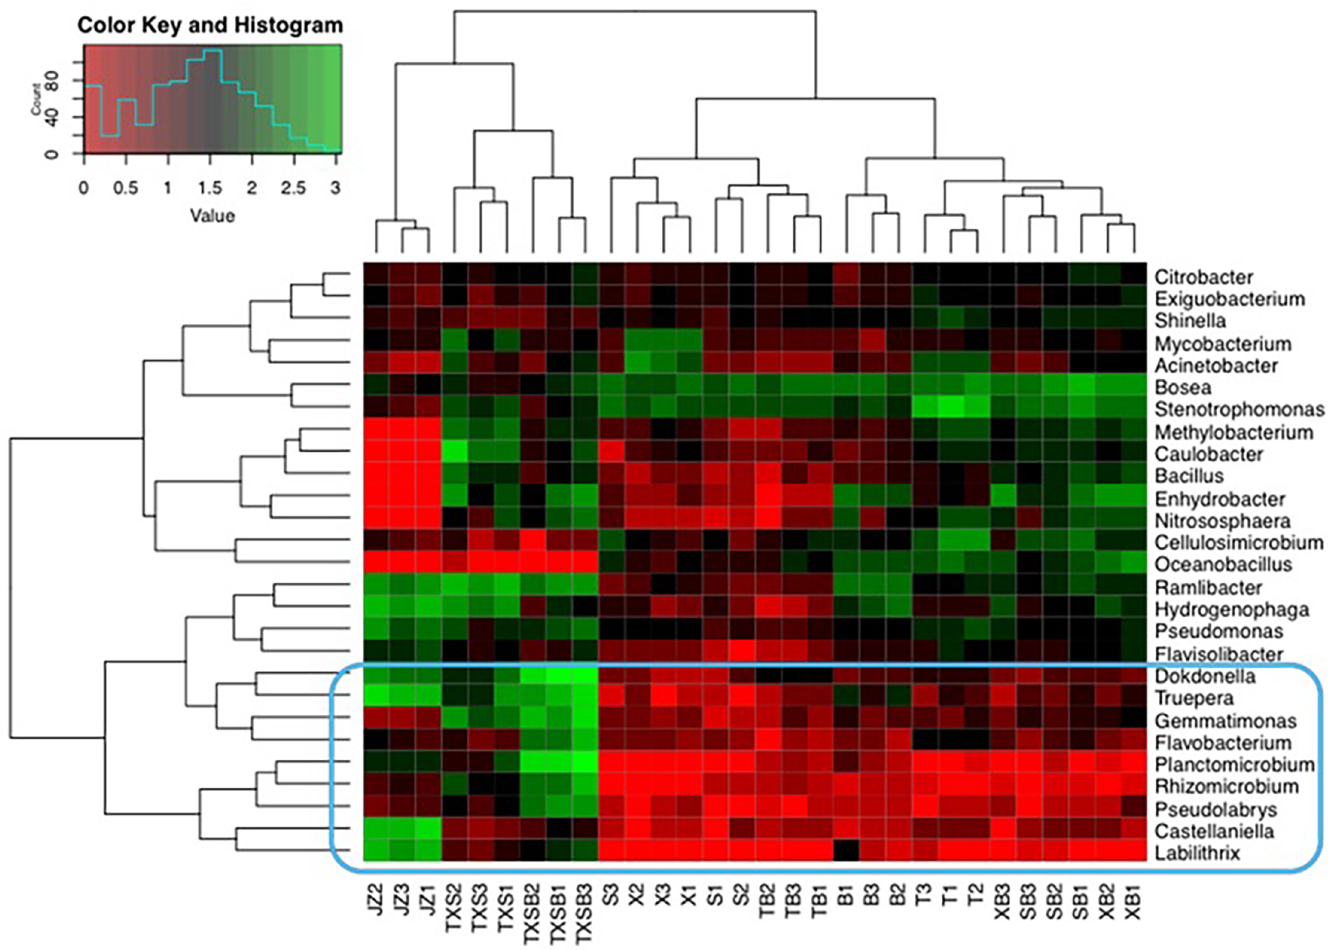
Fig 7. The heatmap of genera with relative abundances between 0.1% with 0.5%. B: benzene; T: toluene; X: xylene; S: styrene; JZ: inoculum; BTF: Biotrickling